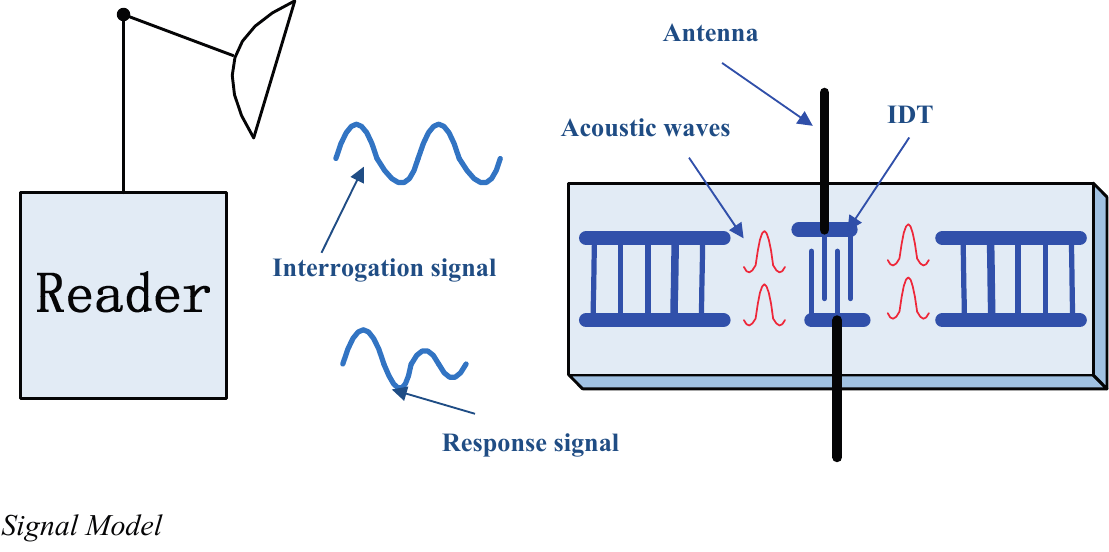
Figure 1. Passive wireless SAW resonant sensor system block